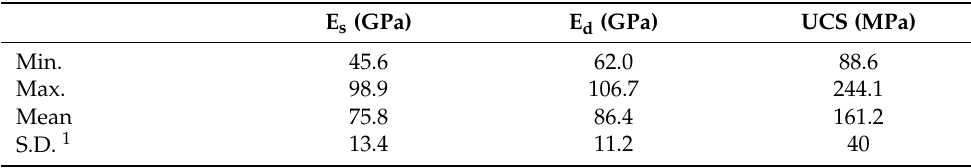
Table 1. Dynamical and mechanical properties of prasinites in this study.